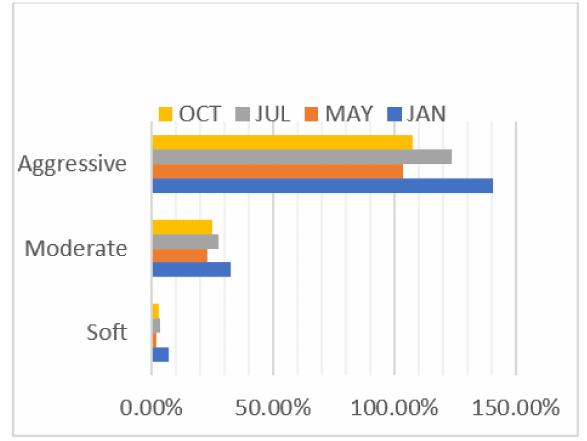
Figure 12. Average monthly increase on pursumers’